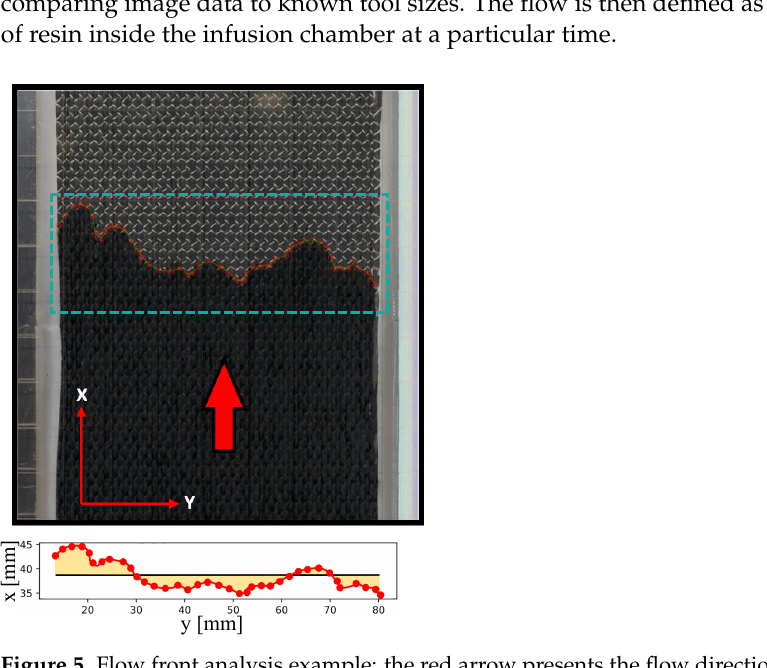
Figure 5. Flow front analysis example: the red arrow presents the flow direction (top figure), and the red line (bottom figure) is the manual recognition of the flow. In the bottom figure, the straight black line is the average value of the flow